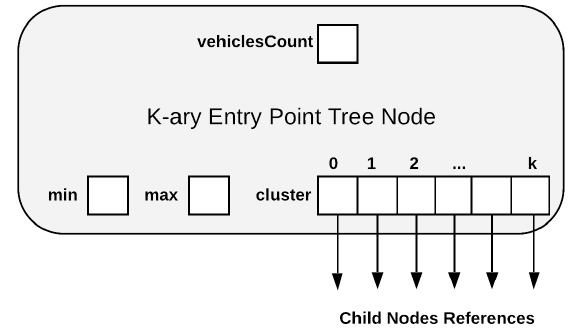
Figure 5. KEP Tree Node